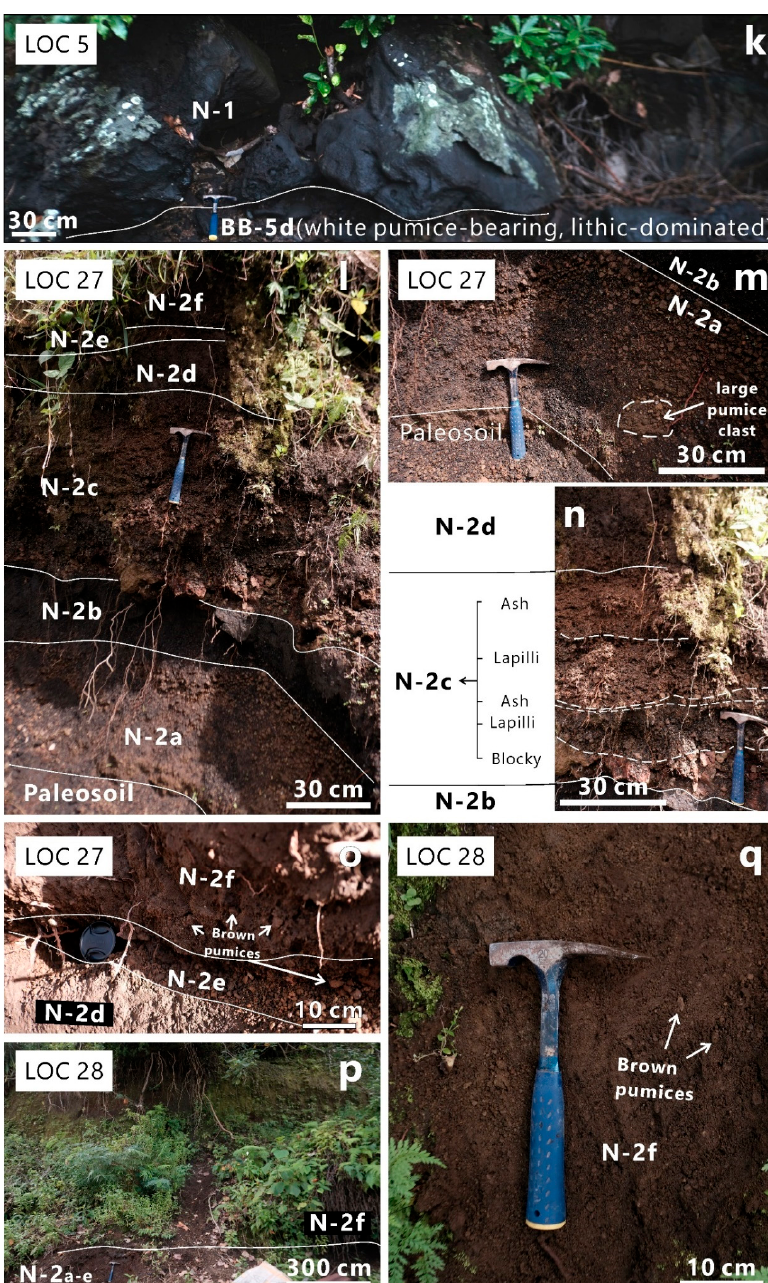
Figure 3. ( a ) Outcrop image of LOC 9, showing the crudely-stratified block- and ash-rich (BB-2) and intercalating lapilli and ash-rich (BB-3) pyroclastic deposits. ( b ) Scoria-rich pyroclastic deposit (BB-4) at LOC 12. ( c ) Outcrop image of LOC 17. The BB-4 is underlined by the sequence of pumice-bearing pyroclastic deposits, including the reversely graded pumice (BB-5a), the intercalating lapilli and ash-rich pumice (BB-5b), and the massive and ash-rich pumice deposits (BB-5c). ( d ) Outcrop image of LOC 15, type locality of the BB-5 unit. ( e – g ) Detailed image of the reversely graded pumice BB-5a, where the upper part has coarser clast sizes than those of the lower part. ( h ) Detailed image of the BB-5b, showing the intercalation of lapilli and the ash-rich layer. ( i , j ) Outcrop images at LOCs 11 and 8, showing the normally graded, fine-depleted, pumice-poor, and lithic-dominated pyroclastic deposits (BB-5d). ( k ) Outcrop at LOC 5 showing the contact between BB-5 and Naira lava (N-1). ( l ) Type locality of Naira pumice deposits (N-2), consisting of six pumice layers (N2 a–f). Detailed images of N-2a ( m ), N 2b–d ( n ), and dN-2e–f ( o ). ( p ) The thickest N-2f deposit is observed at LOC 28. ( q ) Detailed image of